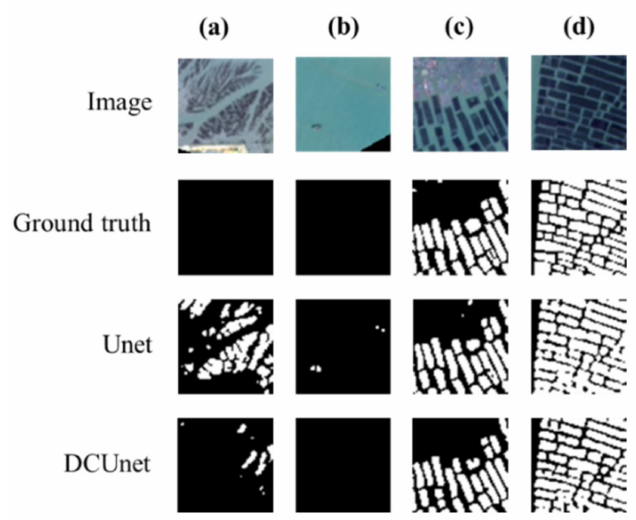
Figure 9. Comparative results of ablation experiments. ( a ) represents scenario containing coastal vegetation, ( b ) represents scenario containing islands, ( c ) represents scenario containing cage, ( d ) represents high density aquaculture